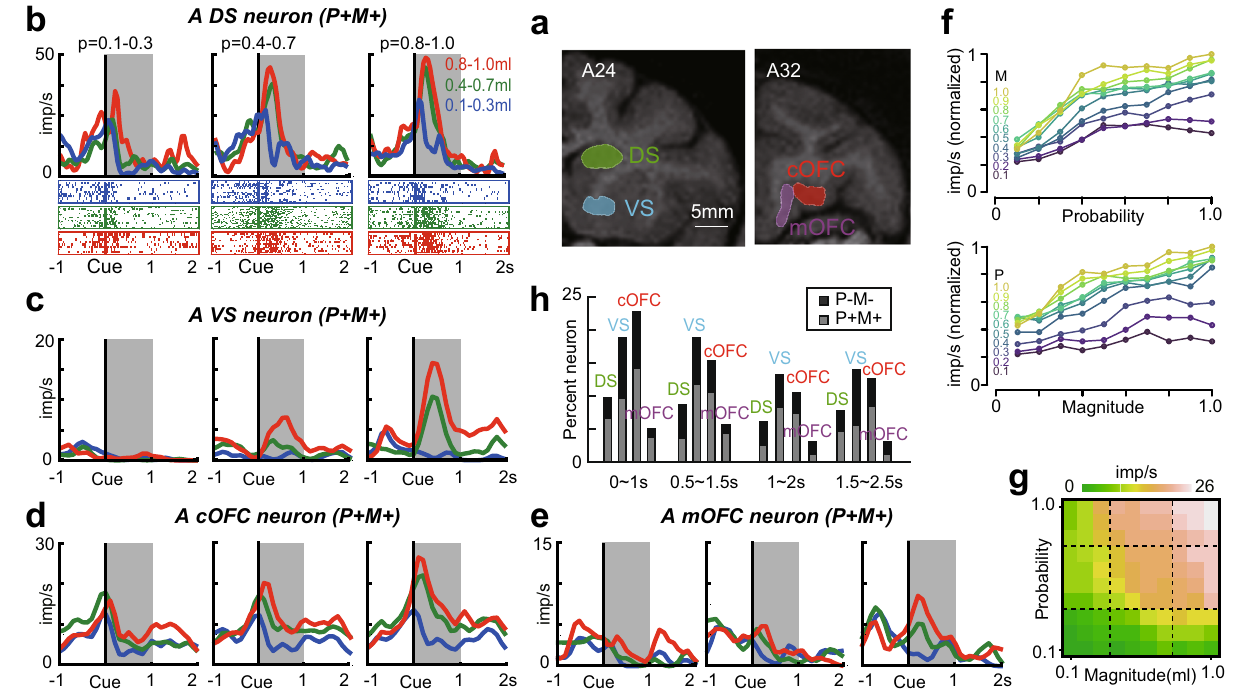
Fig.2|Neuralcodingofprobabilityandmagnitudeofrewardsinthefourbrain regions. a Illustration of neural recording areas based on coronal magnetic reso- nance images. b Example activity histogram of a DS neuron modulated by prob- ability and magnitude of rewards with positive regression coef fi cients during the single-cue task ( P + M +type). The activity aligned to the cue onset is represented for three different levels of probability (0.1 – 0.3, 0.4 – 0.7, and 0.8 – 1.0) and magni- tude (0.1 – 0.3mL, 0.4 – 0.7mL, and 0.8 – 1.0mL) of rewards. Gray hatched time